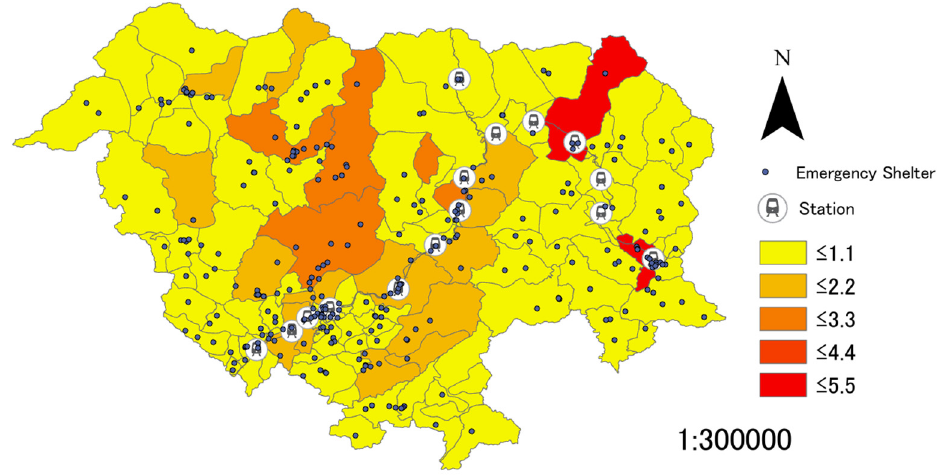
ffi cient. Geosciences 2019 , 9 , x FOR PEER REVIEW